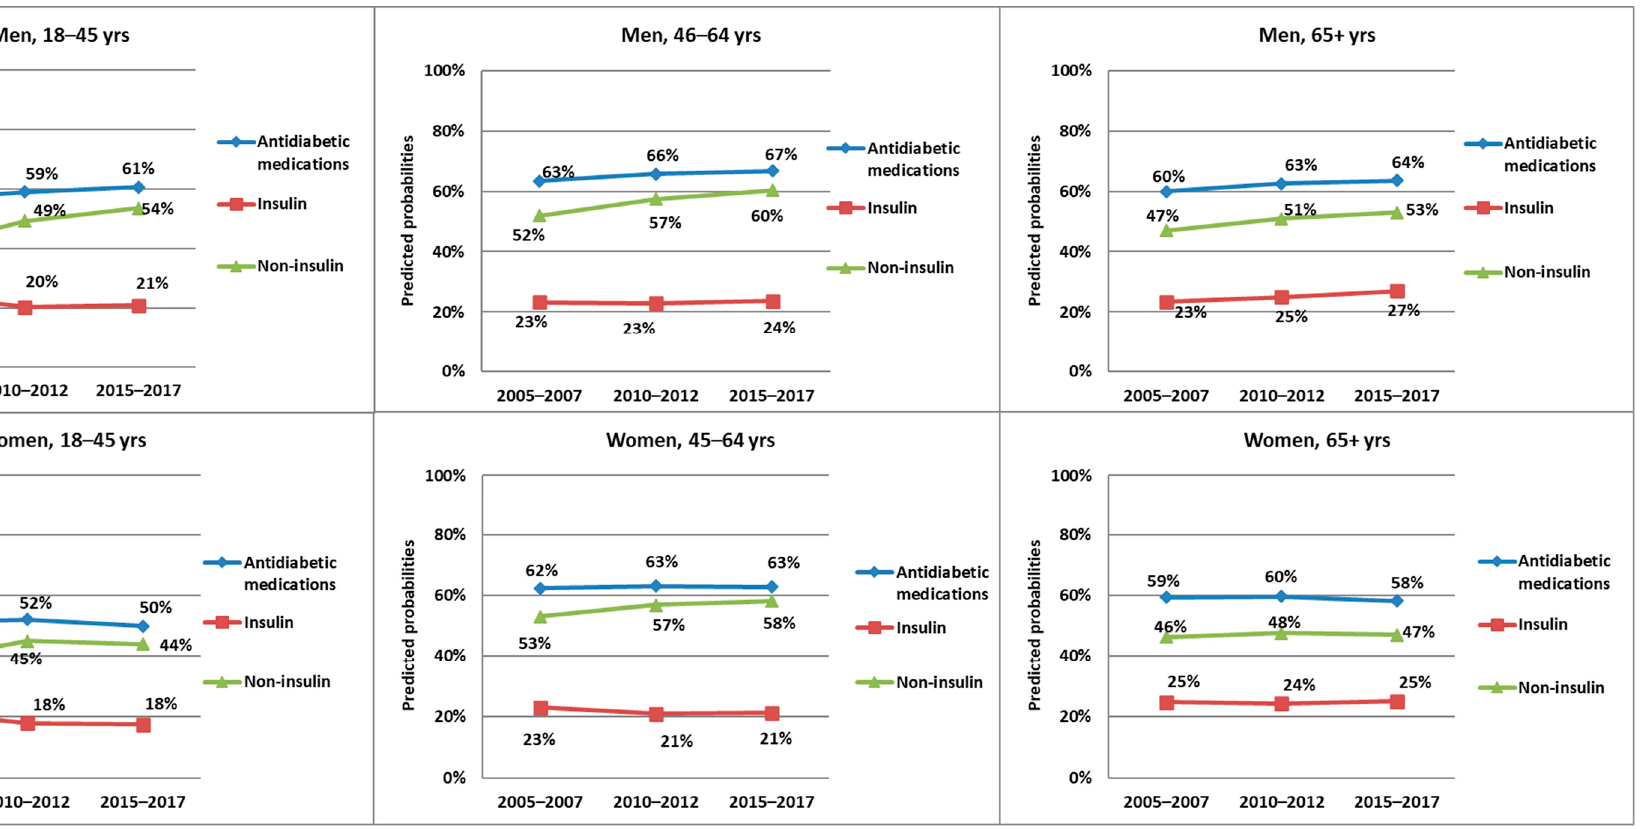
Figure 2. Predicted probabilities of the prescription of antidiabetic medications (at least one of the two subgroups: insulin, non ‐ insulin), insulin, and non ‐ insulin over the three time periods, stratified by gender and three age groups.